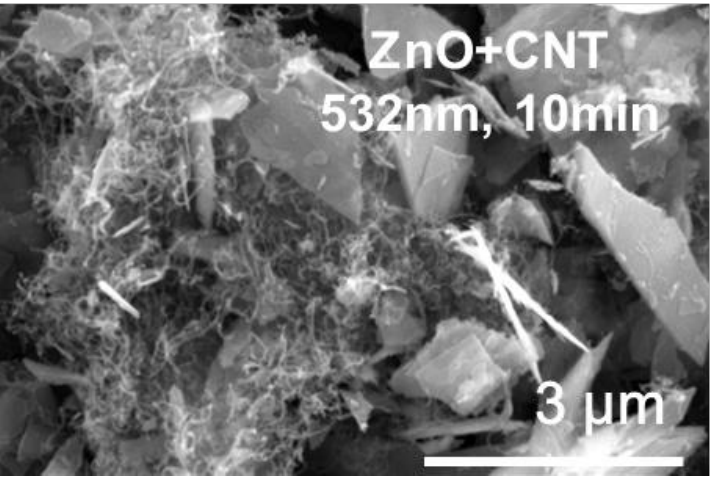
Figure 3. Scanning electron microscopy images for ZnO NS-CNT (532 nm, 10 min).